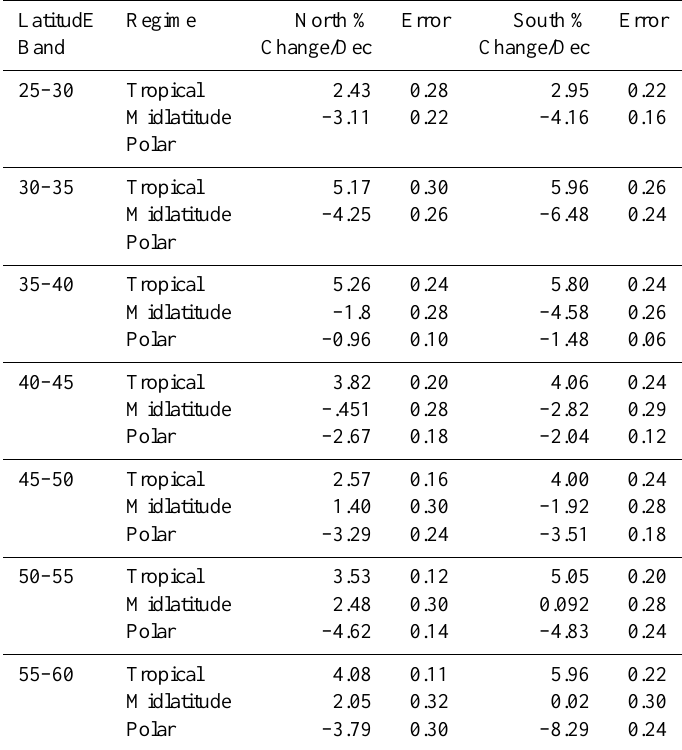
Table 2. Increase/decrease of the area of the regimes for the Northern and Southern Hemisphere for 5 degree latitude bands between 25 and 60 ◦ . The change is expressed as the per cent change per decade. The errors are 2 σ